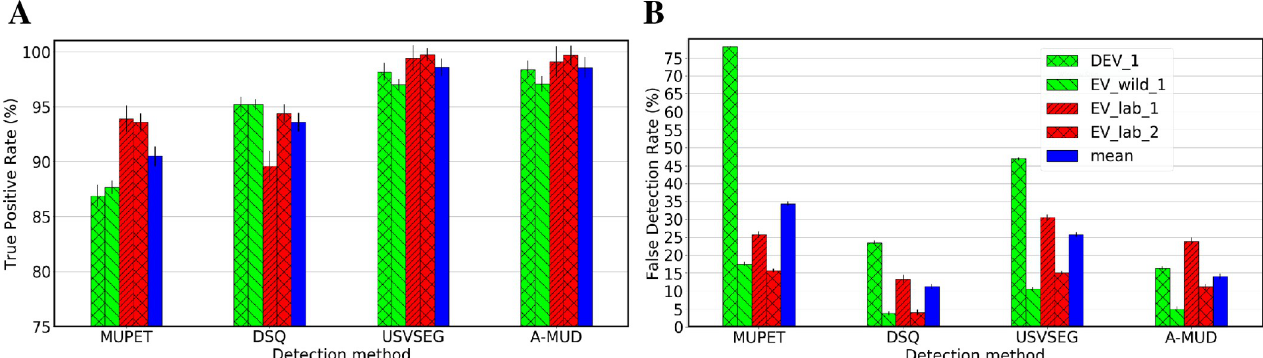
Fig 4. Best performance of four USV detection methods for four recordings. (A) The True Positive Rate shows the ratio of the number of USVs correctly detected to the total number of manually detected USVs � 100. (B) The False Detection Rate shows the ratio of the number of unwanted sounds (noise) incorrectly detected as USVs to the total number of detected elements � 100. Error bars represent the estimated variance calculated from the bootstrap resampling method. MUPET was implemented with the noise-reduction parameter set at 2, minimum syllable duration of 5 ms, and a minimum frequency of 30 kHz [13]. DSQ used its detection with the short rat call_network_v2 network with a high “recall” parameter [16]. USVSEG applied its detection with the threshold parameter set at 2.5, the minimum gap between syllables at 5 ms, and the minimum length of USVs at 4 ms [29]. A-MUD was run using its default parameters [30]. The legend shows the four recordings that were compared for each method (i.e., laboratory mice vs wild mice for both DEV (i.e., DEV_1 and EV_wild_1) and EV datasets (i.e., EV_lab_1 and EV_lab_2) and the mean of these four recordings. DEV_1 and EV_lab_1 are examples of low-SNR recordings and EV_lab_2 is an example of high-SNR